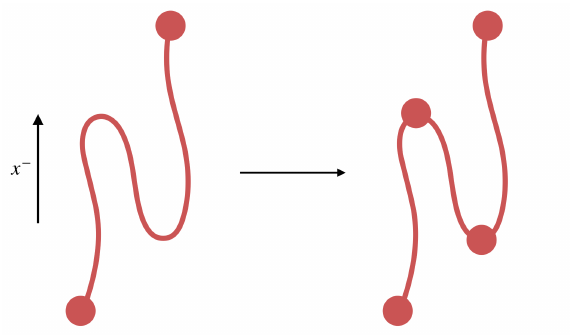
Figure 4 . Splitting of a turning worldline into several monotonic